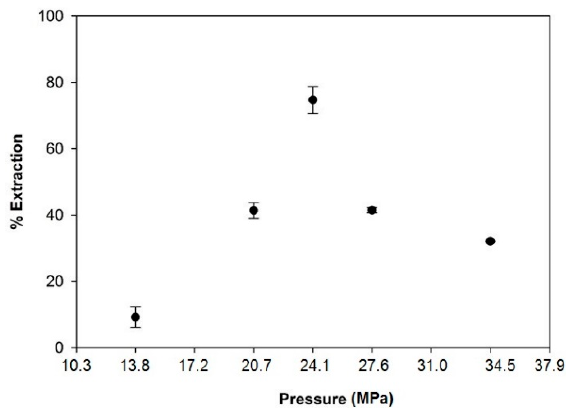
Figure 7. The percent extraction of Eu from 1000 mg/kg Eu 8 M HCl solution with TBDGA in CO 2( l ) modified with 2 mol% 1 ‐ octanol as a function of pressure (13.8–34.5 MPa) at 23 °C.